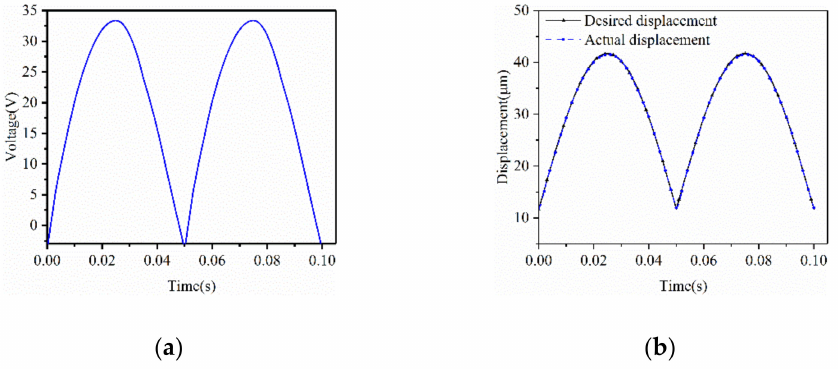
Figure 7. ( a ) The exciting u ( t ) after compensation of the rate-dependent PI model; ( b ) Actual displacements after compensation and desired displacements.